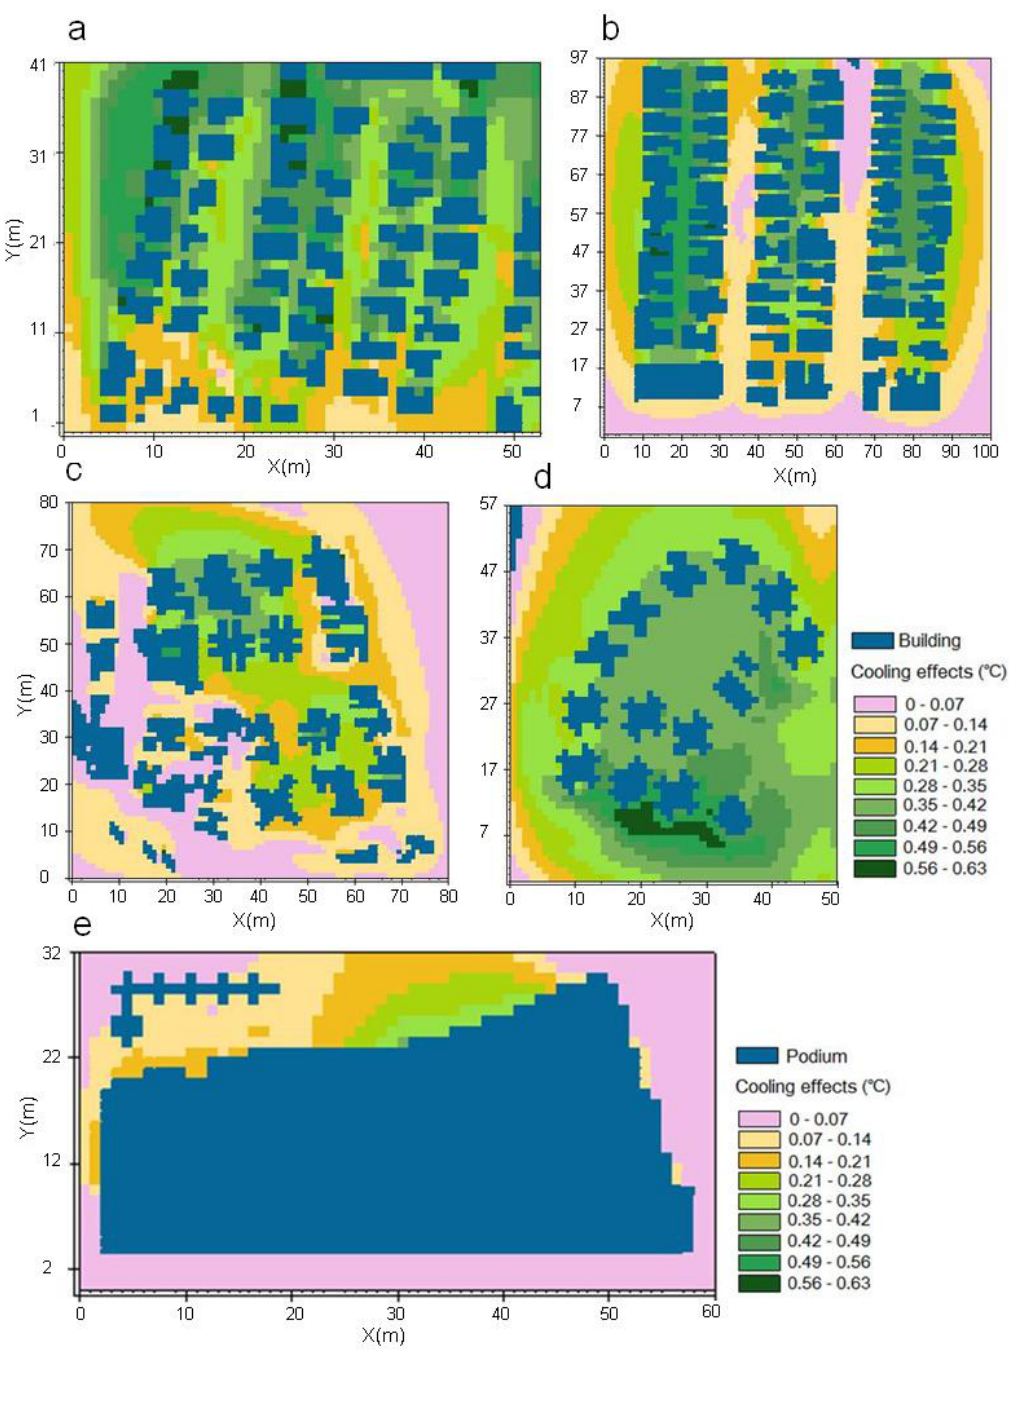
Figure 7. Horizontal distribution of cooling effects for EGR at the pedestrian level at 14:00 (cooling effects refer to the air-temperature differences between the bare